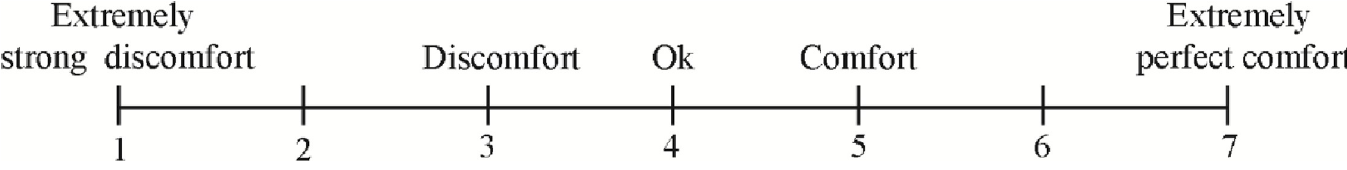
PLOS ONE | https://doi.org/10.1371/journal.pone.0276900 February 13,